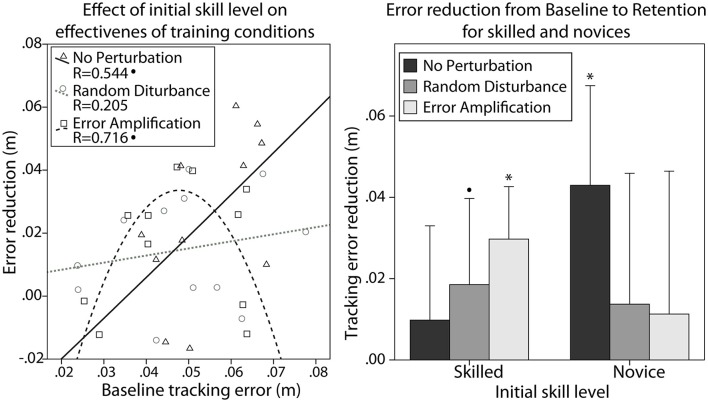
(Left) Effect of initial skill level (i.e., tracking error during baseline) on the error reduction from baseline to retention with the different training strategies. (Right) Error reduction after training with the different training strategies, in the skilled and novice groups. Error bars show ± 1 CI. *p < 0.05, •p < 0.1.